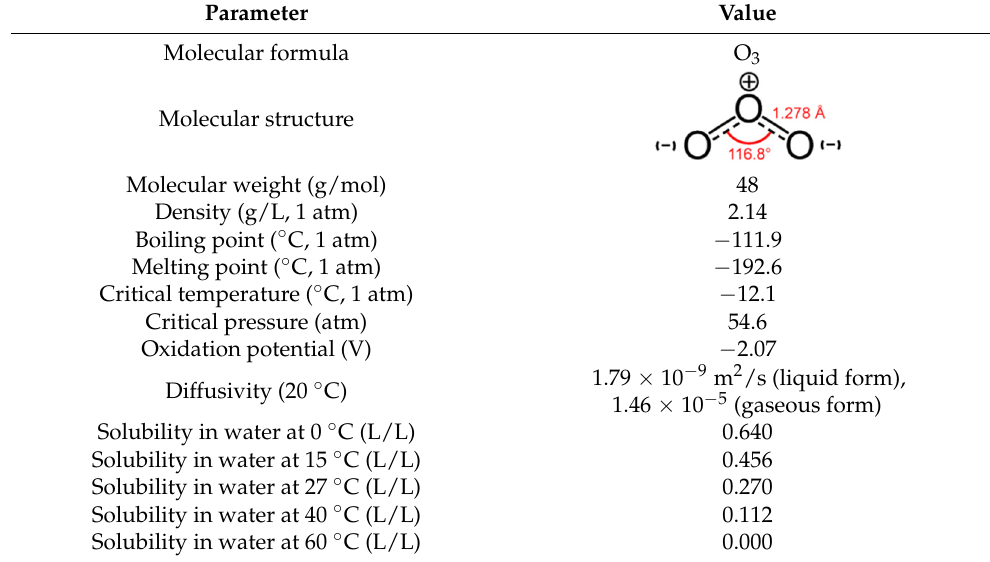
Table 1. Ozone structure and property [21,23,24].